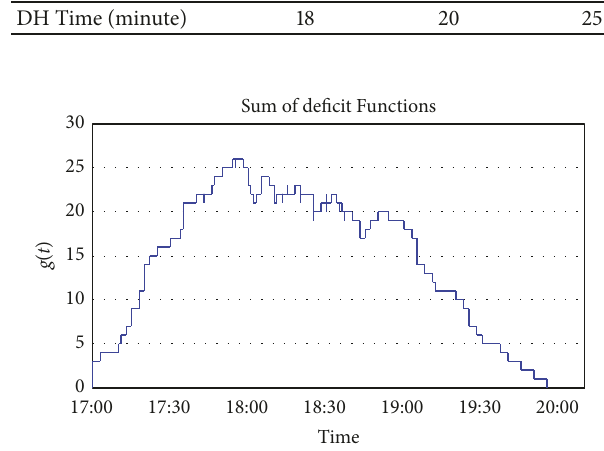
Figure 7: Sum of deficit functions (of vehicles in service).